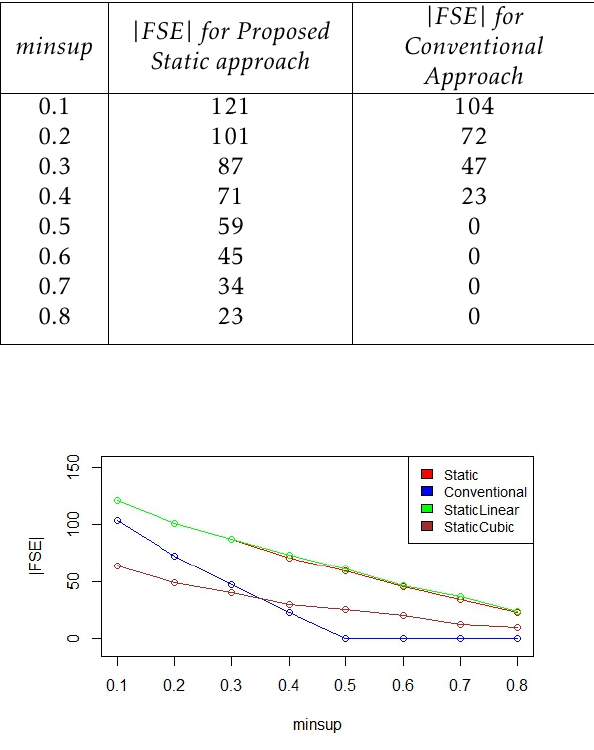
Table 10. Number of frequent singleton edges (|FSE|) for graph stream data with varying minsup for proposed static approach compared to Conventional Approach |FSE| for Proposed minsup